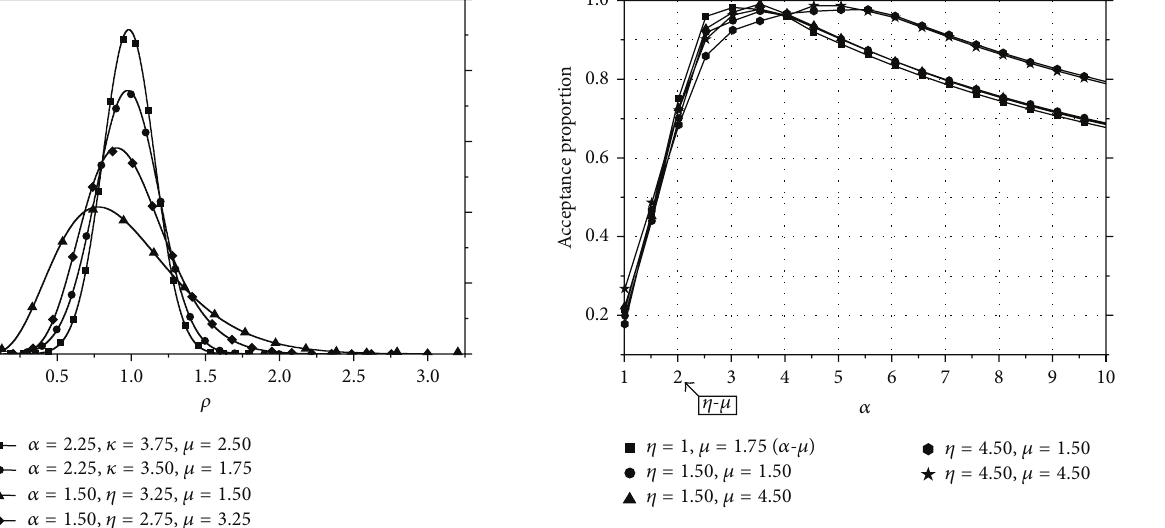
Figure 3: Rejection method efficiency for the 𝛼 - 𝜂 - 𝜇